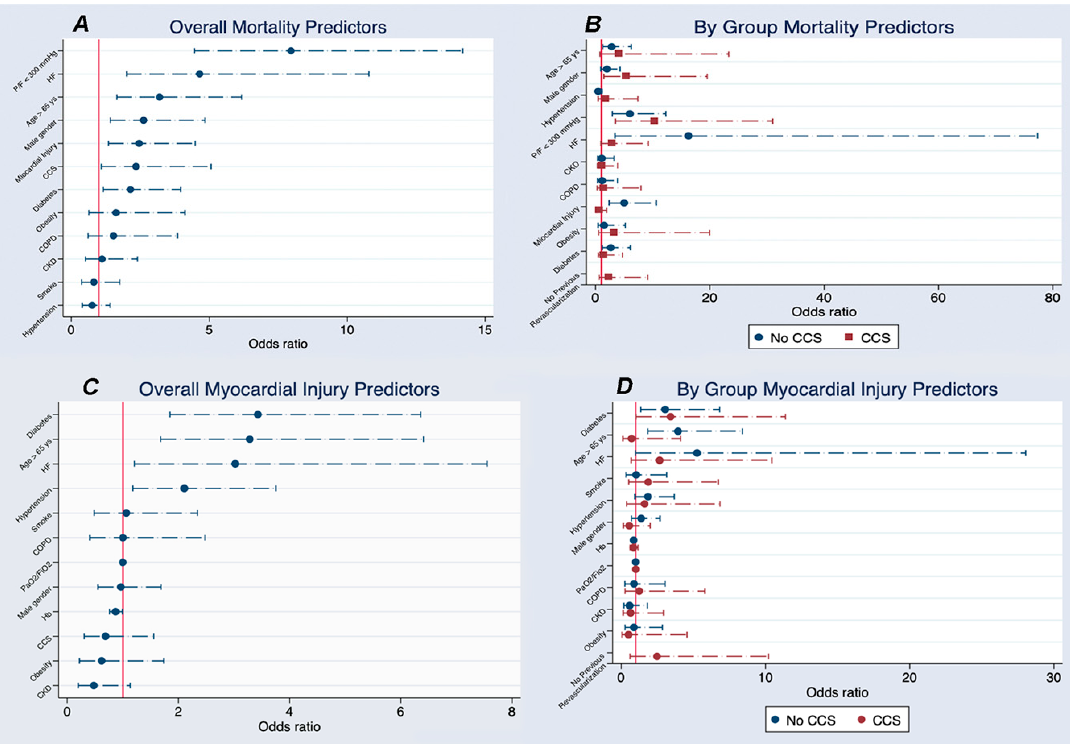
regression for mortality. Panel B: stratification of in-hospital mortality between CCS and non-CCS patients. Panel C: overall multivariate logistical regression for myocardial injury. Panel D: stratification of myocardial injury between CCS and non-CCS patients. Abbreviations : CCS: chronic coronary syndromes; CKD: chronic kidney disease; COPD: chronic obstructive pulmonary disease; Hb: hemoglobin; HF: heart failure; P / F: PaO 2 / FiO 2 ratio; ys: